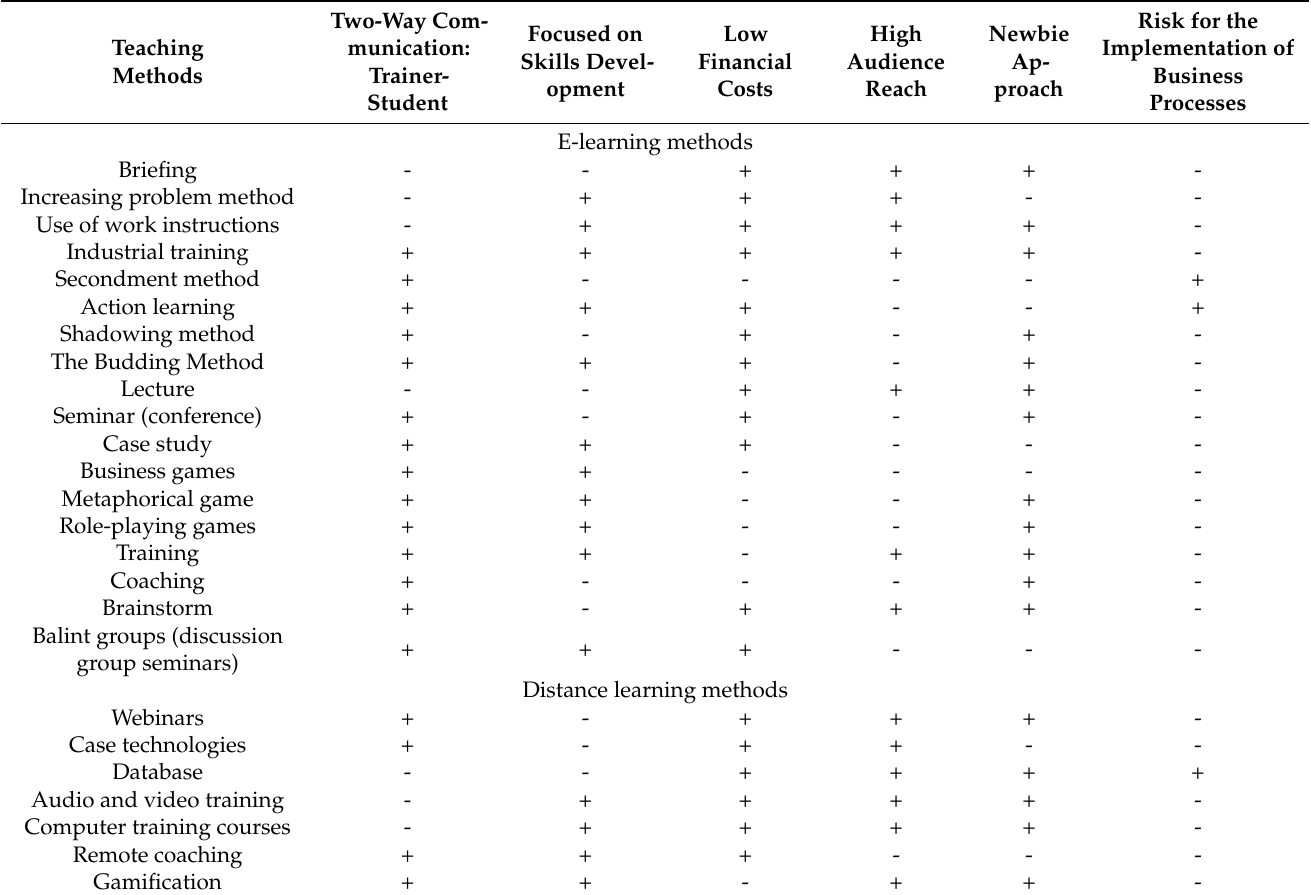
Table 1. Characteristics of digital staff training